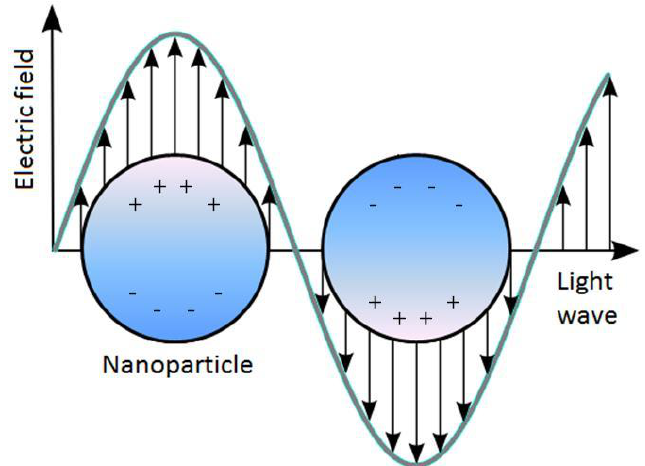
Figure 1. Schematic of localized surface plasmon resonance (LSPR) where the free conduction electrons in the metal nanoparticle are driven into oscillation due to strong coupling with incident